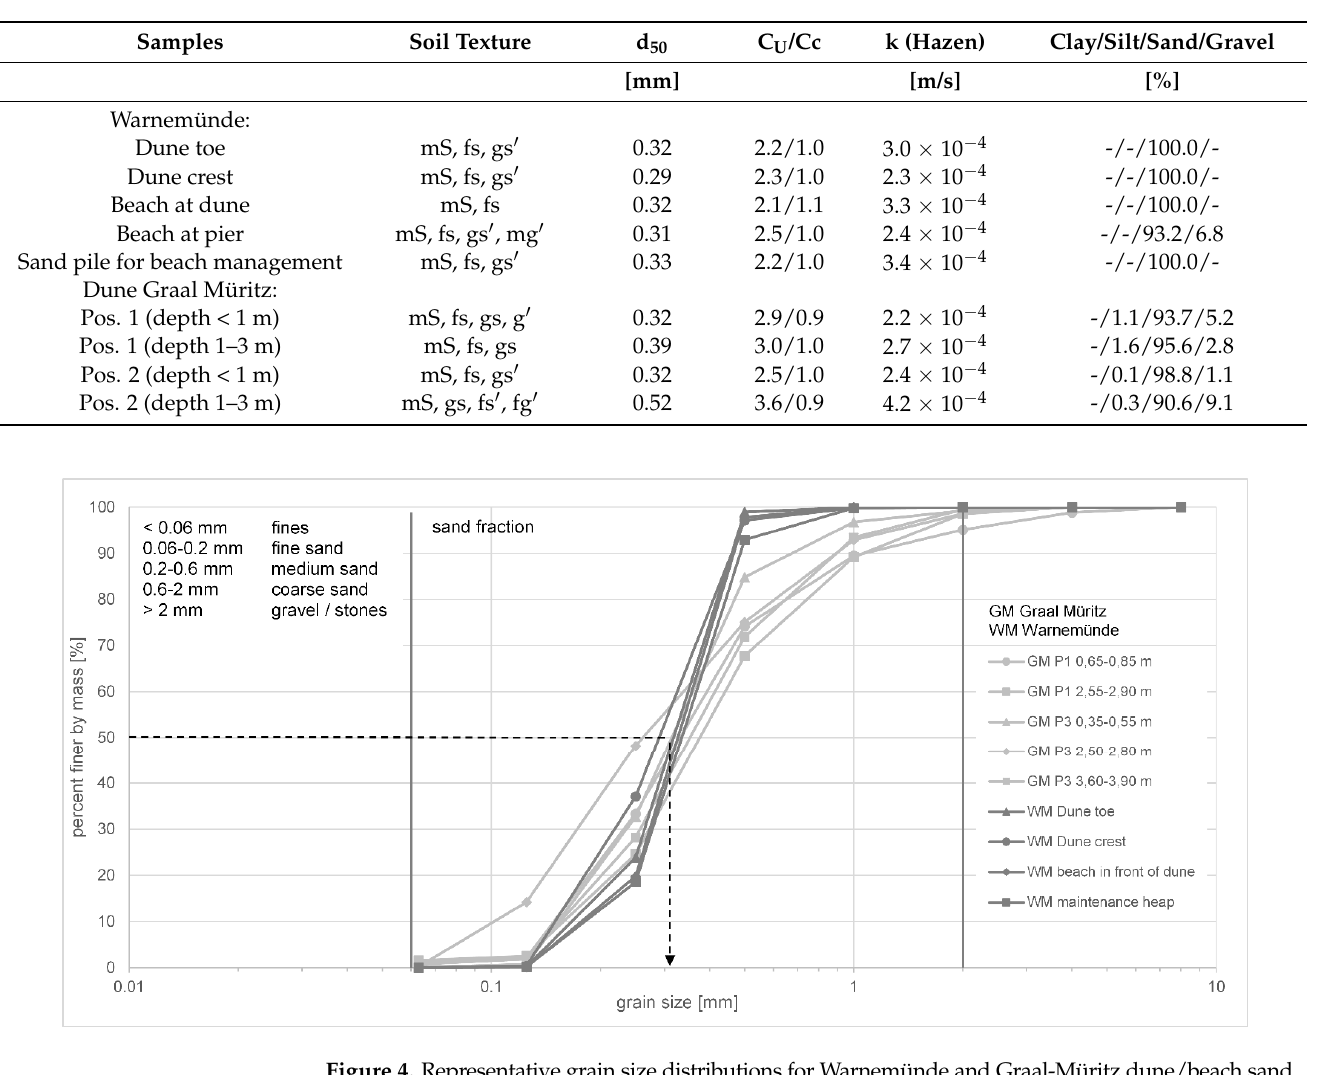
Table 1. Basic characterisation of Warnemünde and Graal Müritz dune/beach sand.